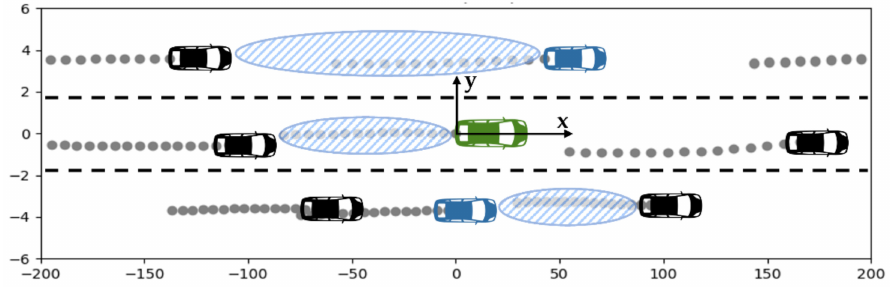
Figure 2. Coordinate system used for trajectory prediction. Green: target vehicle, blue: nearest vehicle in adjacent lane, patterned ellipse: front and rear inter-vehicle distance.